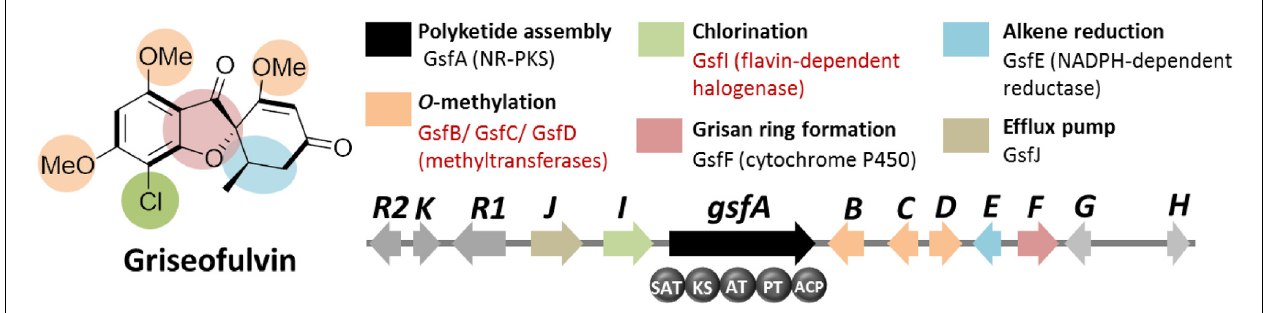
FIGURE 4 | Griseofulvin biosynthetic gene clusterin P. aethiopicum . Shown are the roles of the genes in the biogenesis of the compound.The non-reducing polyketide synthase (NR-PKS) gene gsfA is found via